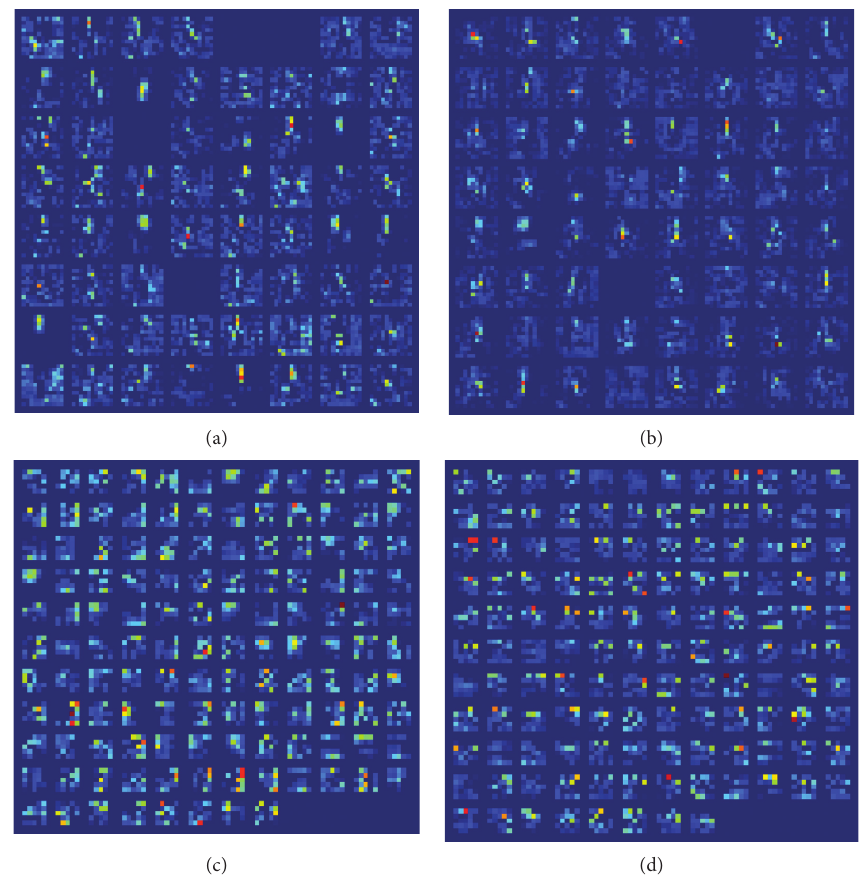
Figure 10: Visualization of feature maps: (a) output by first SE module; (b) output by first SoftPool-SE module; (c) output by second SE module; (d) output by second SoftPool-SE